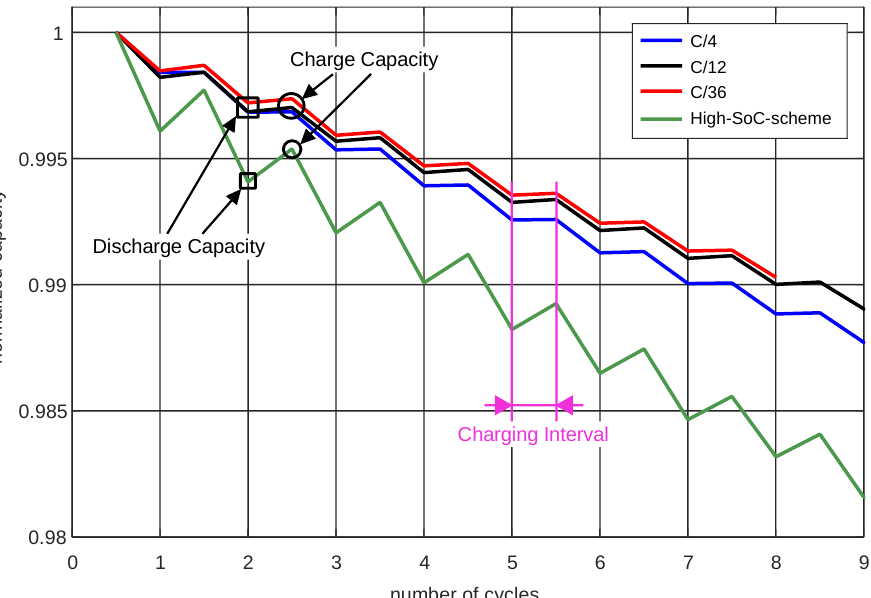
Figure 14. Capacity degradation for the C/x-scheme measurements with a cycling current C/4, C/12 and C/36 and high-SoC-scheme at 40 °C. With the C/x-schemes, almost no leakage charge or charge cycling losses occur. The high-SoC-scheme degrades faster than the C/x-schemes indicating significant calendrical aging and also has a significant amount of leakage